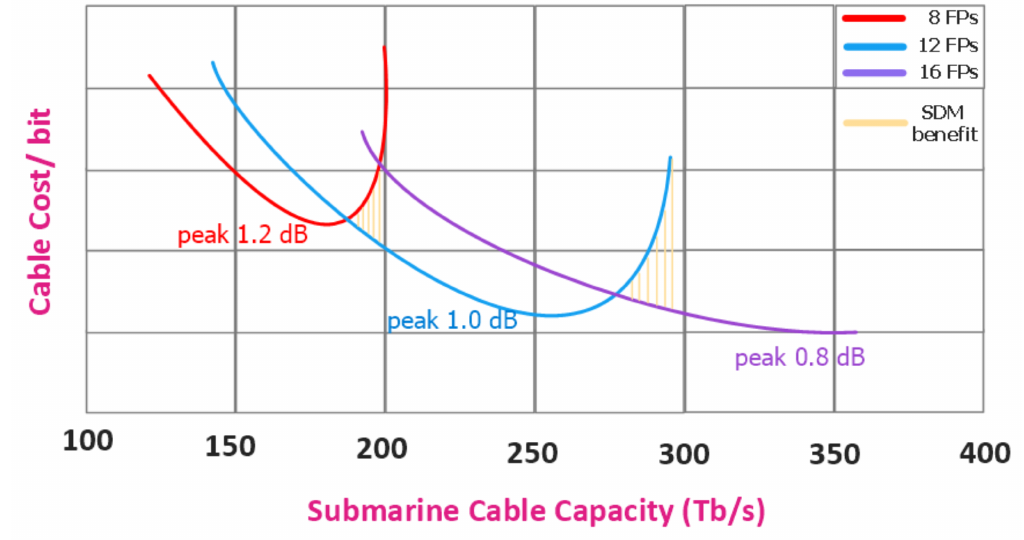
Figure 34. Cable cost per bit for 8, 12 and 16 FPs